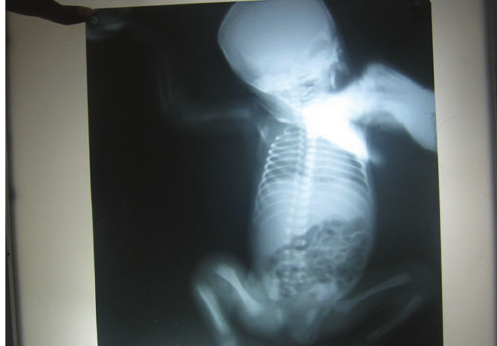
Figure 5: Radiograph of long bones: distal end of femur showing erosions.